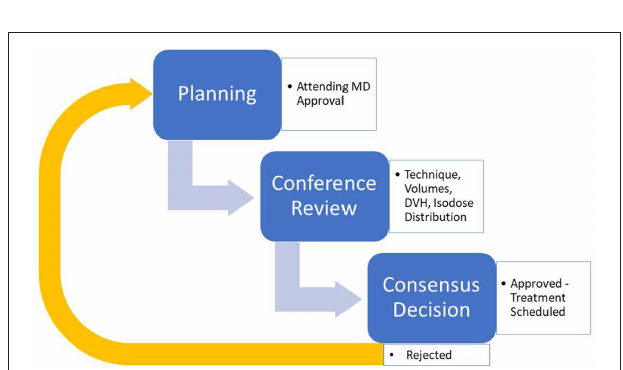
FIGURE 1 | Example of automated DVH analysis using Pinnacle Scorecard.